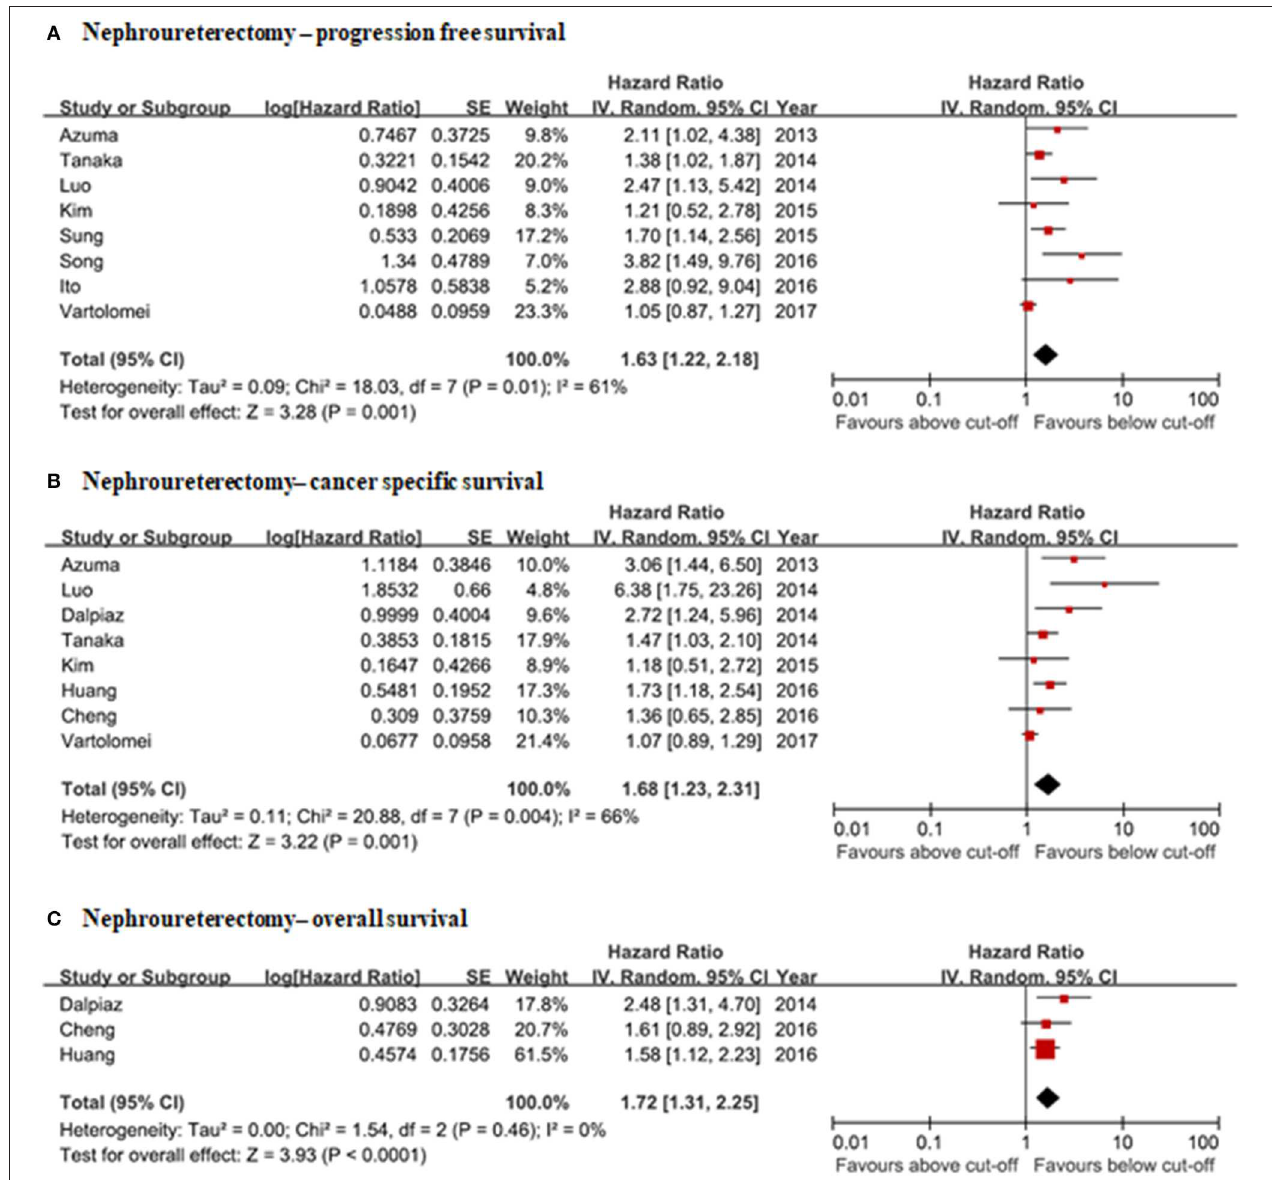
FIGURE 6 | Forrest plots of the relationship between NLRs and clinical information in nephroureterectomy patients. (A) Nephroureterectomy—progression free survival. (B) Nephroureterectomy—cancer specific survival. (C) Nephroureterectomy—overall